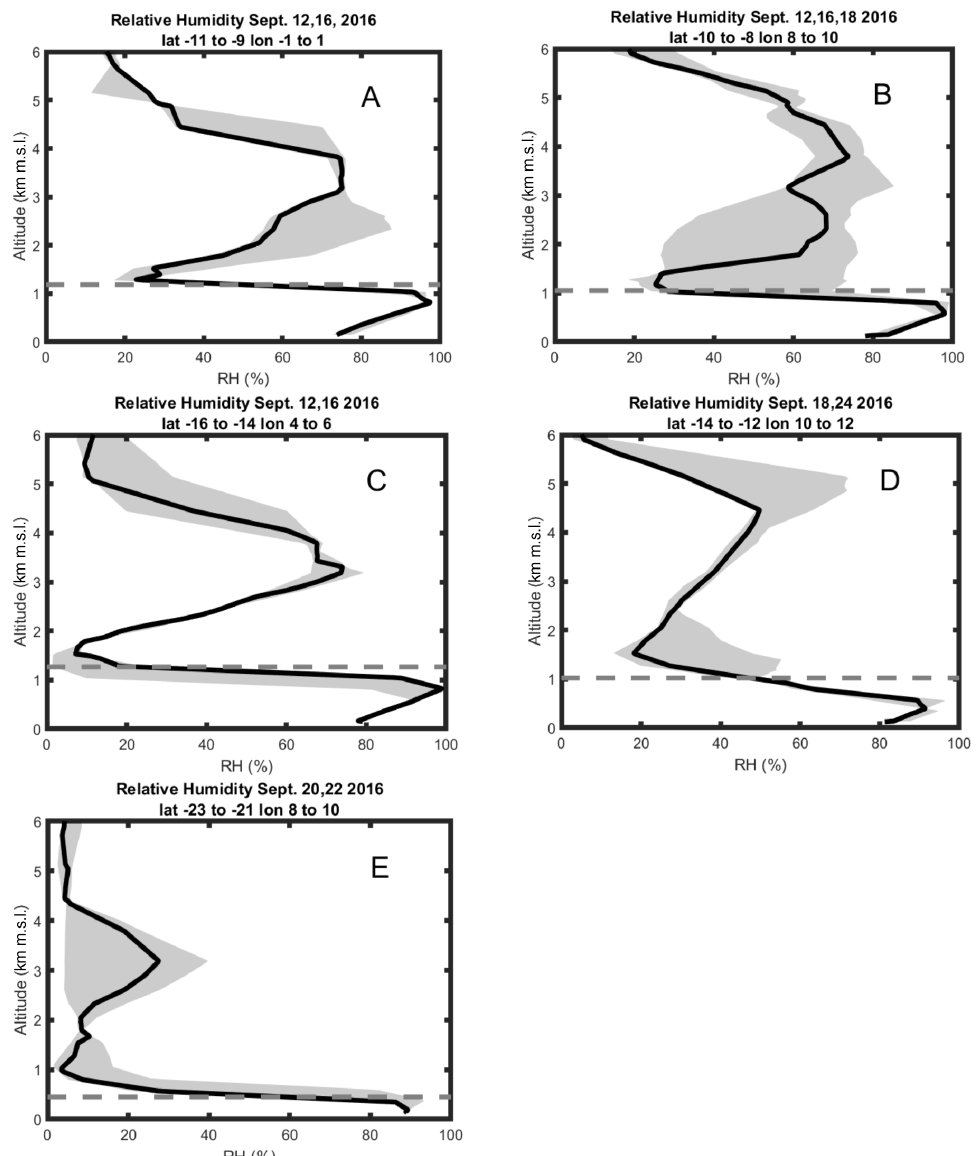
Figure 10. Relative humidity (%) in grid boxes A (upper left), B (upper right), C (middle left), D (middle right), and E (lower left) from MERRA2 reanalysis corresponding to the HSRL-2 profiles shown in Figs. 6–9. The dark line represents the median value and gray shades contain the 25th to 75th percentiles. Dashed line refers to the mean cloud top